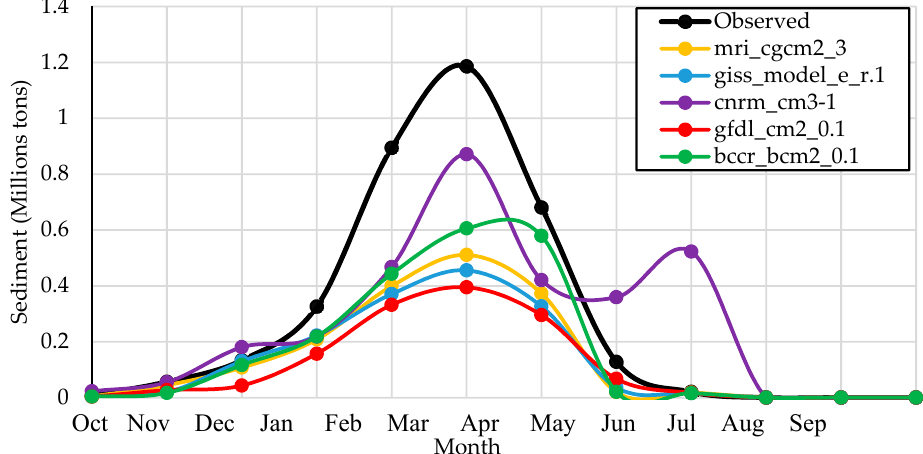
Figure 14. Impact of climate change on simulated sediment of the Derbendkhan Watershed for the period from 2015 to 2050.